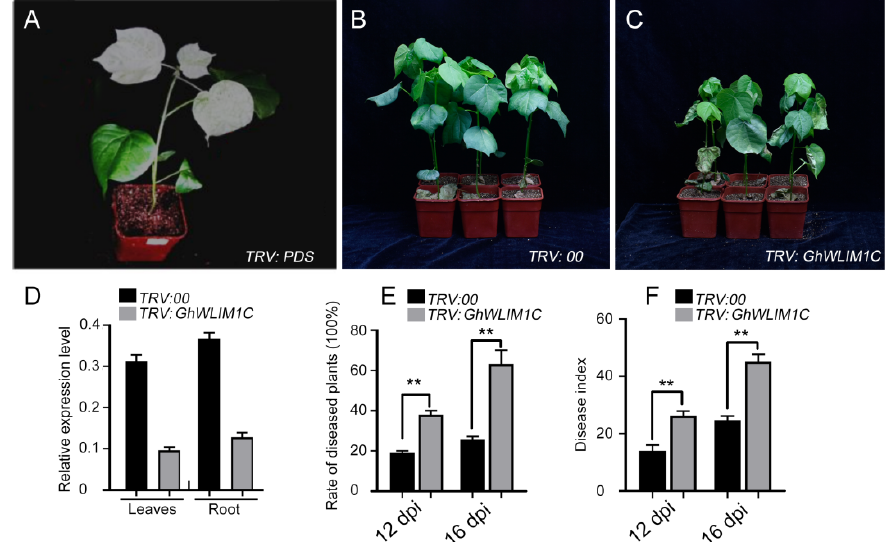
Figure 2. GhWLIM1C silencing decreases resistance to V. dahliae infection in cotton. ( A ) Preliminary assay of the efficiency of VIGS under our experimental conditions. Ten-day-old cotton plants were infiltrated with Agrobacterium carrying TRV:PDS . The photographs were taken 2 weeks after infil- tration. ( B , C ) Phenotypes of control ( B ) and GhWLIM1C silenced cotton plants ( C ). Cotton plants were infiltrated with Agrobacterium carrying VIGS-control vector ( TRV:00 ) or ( TRV:GhWLIM1C ) and inoculated with a suspension of V. dahliae spores. Photographs were taken 2 weeks after V. dahliae infection. ( D ) qRT-PCR analysis of GhWLIM1C expression in cotton leaves and the root tissues infiltrated with VIGS-control vector ( TRV:00 ) and TRV:GhWLIM1C . Error bars indicate SD from three technical replicates of one biological experiment. The experiments were repeated three times with similar results. ( E , F ) Rate of diseased plants and disease index of TRV:00 and TRV:GhWLIM1C cotton plants. Error bars represent the SD of three biological replicates ( n = 36), and asterisks indicate sta- tistically significant differences, as determined by Student’s t -test (** p < 0.01).